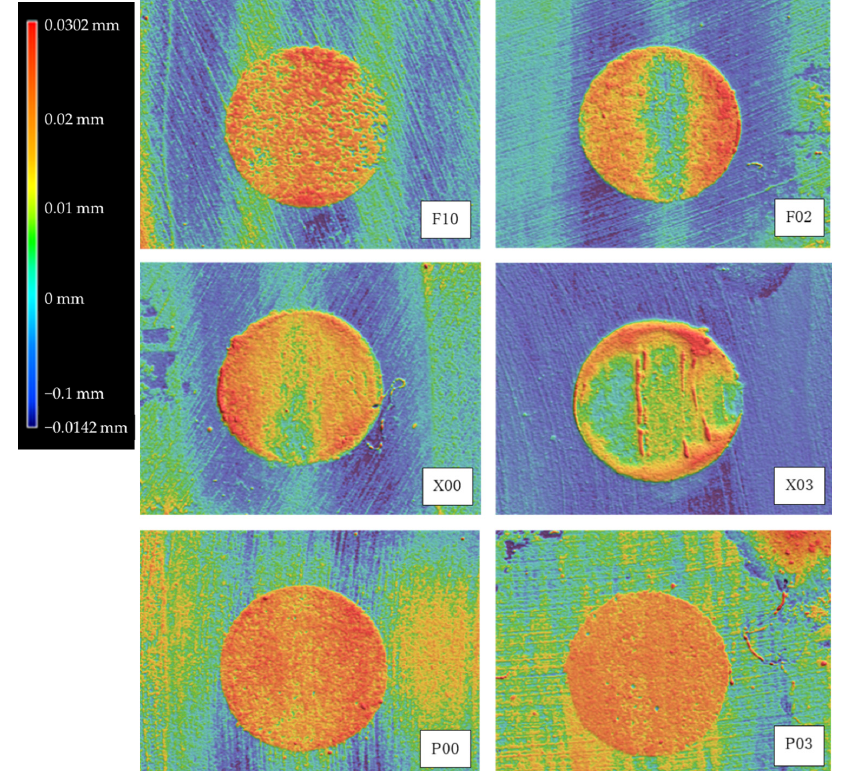
Figure 1. The wear volume of each flowable resin after the toothbrush abrasion test. The wear vol- ume shows a tendency to increase linearly with the number of strokes during the test.